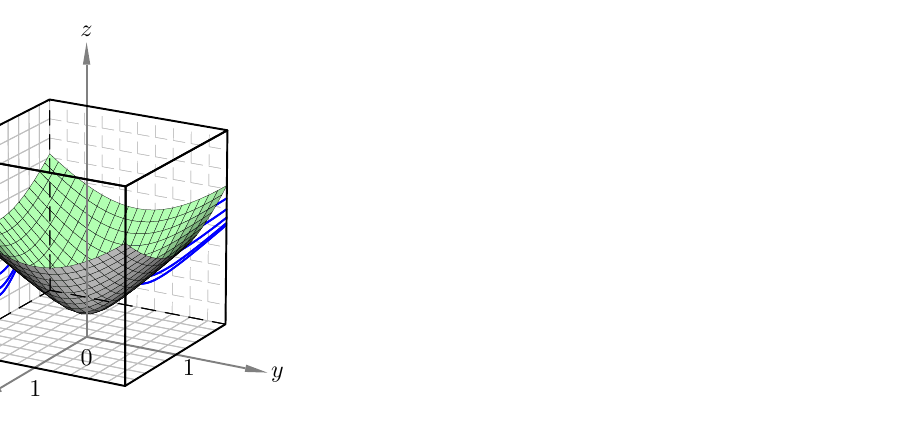
Figure 3. The schematic representation of multiquadric (MQ) radial basis functions (RBF) with shape parameter c =